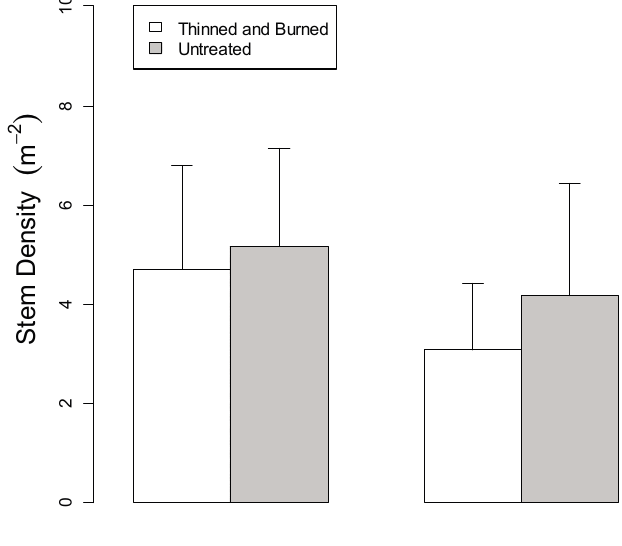
Figure 7. Mean values of field measured shrub stem density in grazed and ungrazed plots that were either thinned and burned or untreated. Standard error bars are